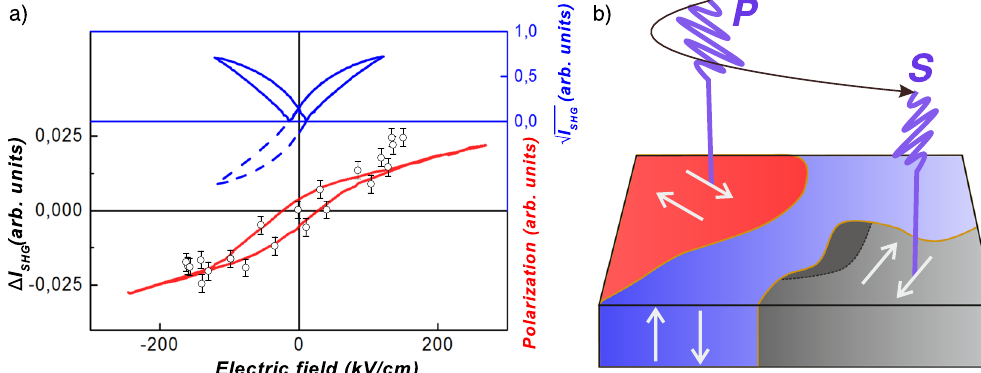
Figure 3. Effect of the electric field on electric polarization and SHG. ( a ) Hysteresis loops of the electric polarization obtained by the Soyer-Tower technique (bottom solid line); SHG hysteresis loop reconstructed from low-frequency measurements (top line). To compare with the hysteresis loop for the electric polarization, left side of the graph is plotted with an inversed sign (dashed line); SHG loops reconstructed from the experiment with THz pump pulses (points). Error bars on Δ I SHG show s.d. from the 15 measured samples; ( b ) diagram showing the domain structure and its sensitivity to the external THz